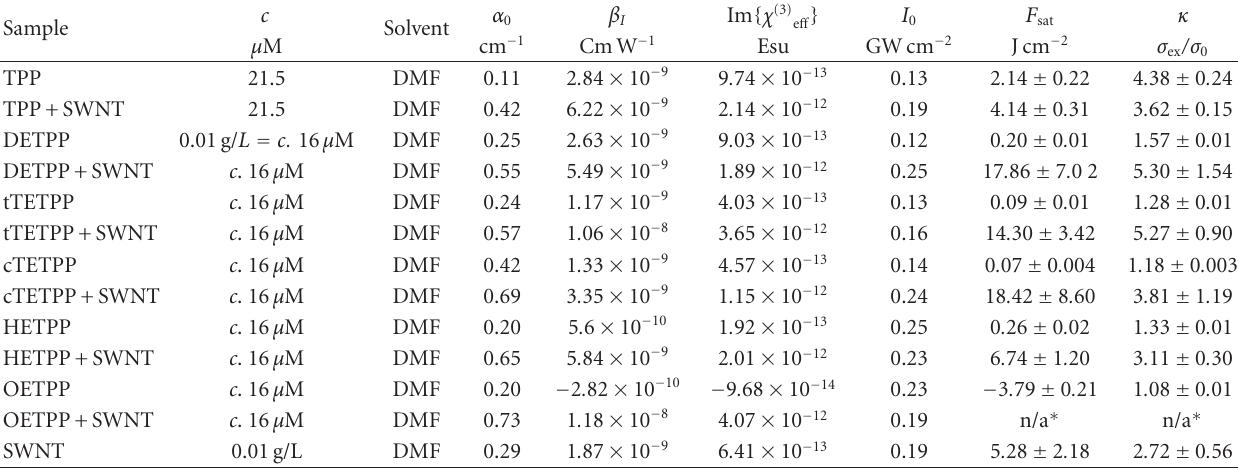
Figure 6: Superior optical limiting behaviour of porphyrin composites is clearly to be seen in these plots of normalised transmission versus pulse energy density. All plots are for onfocus beam intensity I 0 of 0.2 GW/cm 2 (approximately). Table 1: Optical coe ffi cients for the materials